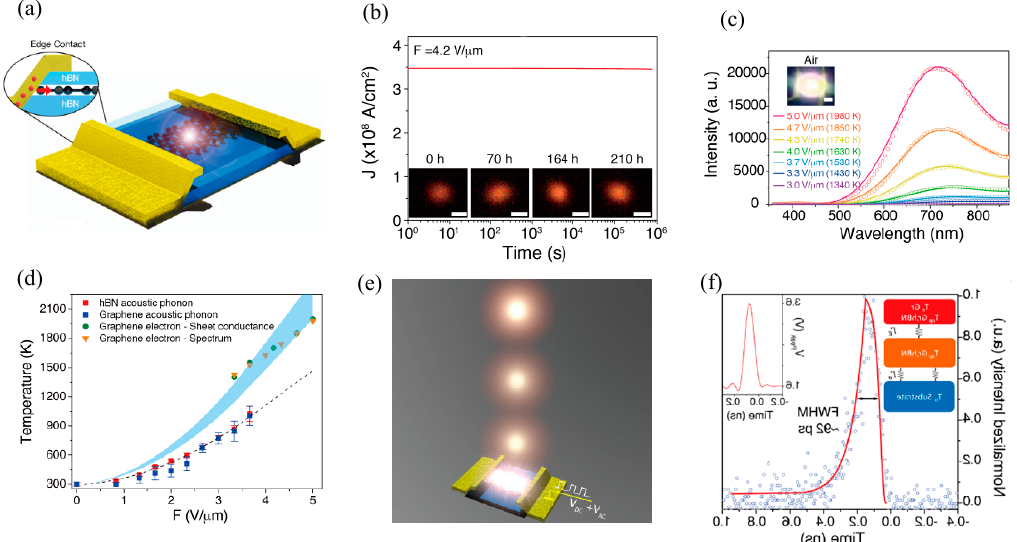
Figure 4. Ultra-fast thermal emission from hBN encapsulated graphene layer ( a ) the fabricated device, where it consists of a single-layer graphene encapsulated with hBN from both sides and edges are connected with source and drain contacts. ( b ) The response of light emitter under static electric field F = 4.2 V/um depicts insignificant variations in the intensity of light emission and current density. ( c ) The response of light emitters under different values of electric field and electric power under the vacuumed condition and air, respectively, under high electric response F = 5.0 V/um, peak emission of 718 nm near-infrared is observed. ( d ) Demonstrates the electronic temperature and derived temperature together under high biasing conditions, the T ap of hBN and graphene are almost equal; however, it is lower than the electronic temperature. ( e) The pulse response from ultrafast light emitter under electric control, where light pulses are verified by the time associated with single-photon counting, ( e ) The ultrafast light pulses (92 ps) from graphene-based light emitters, where solid blue line depicts electrically drive pulse of 80 ps, which refers to the bandwidth of 10 GHz. ( f ) The red line corresponds to the thermal radiations and transient temperature exponential fit where schematic at the left-top side presents the energy relaxation time in the graphene layer [96].